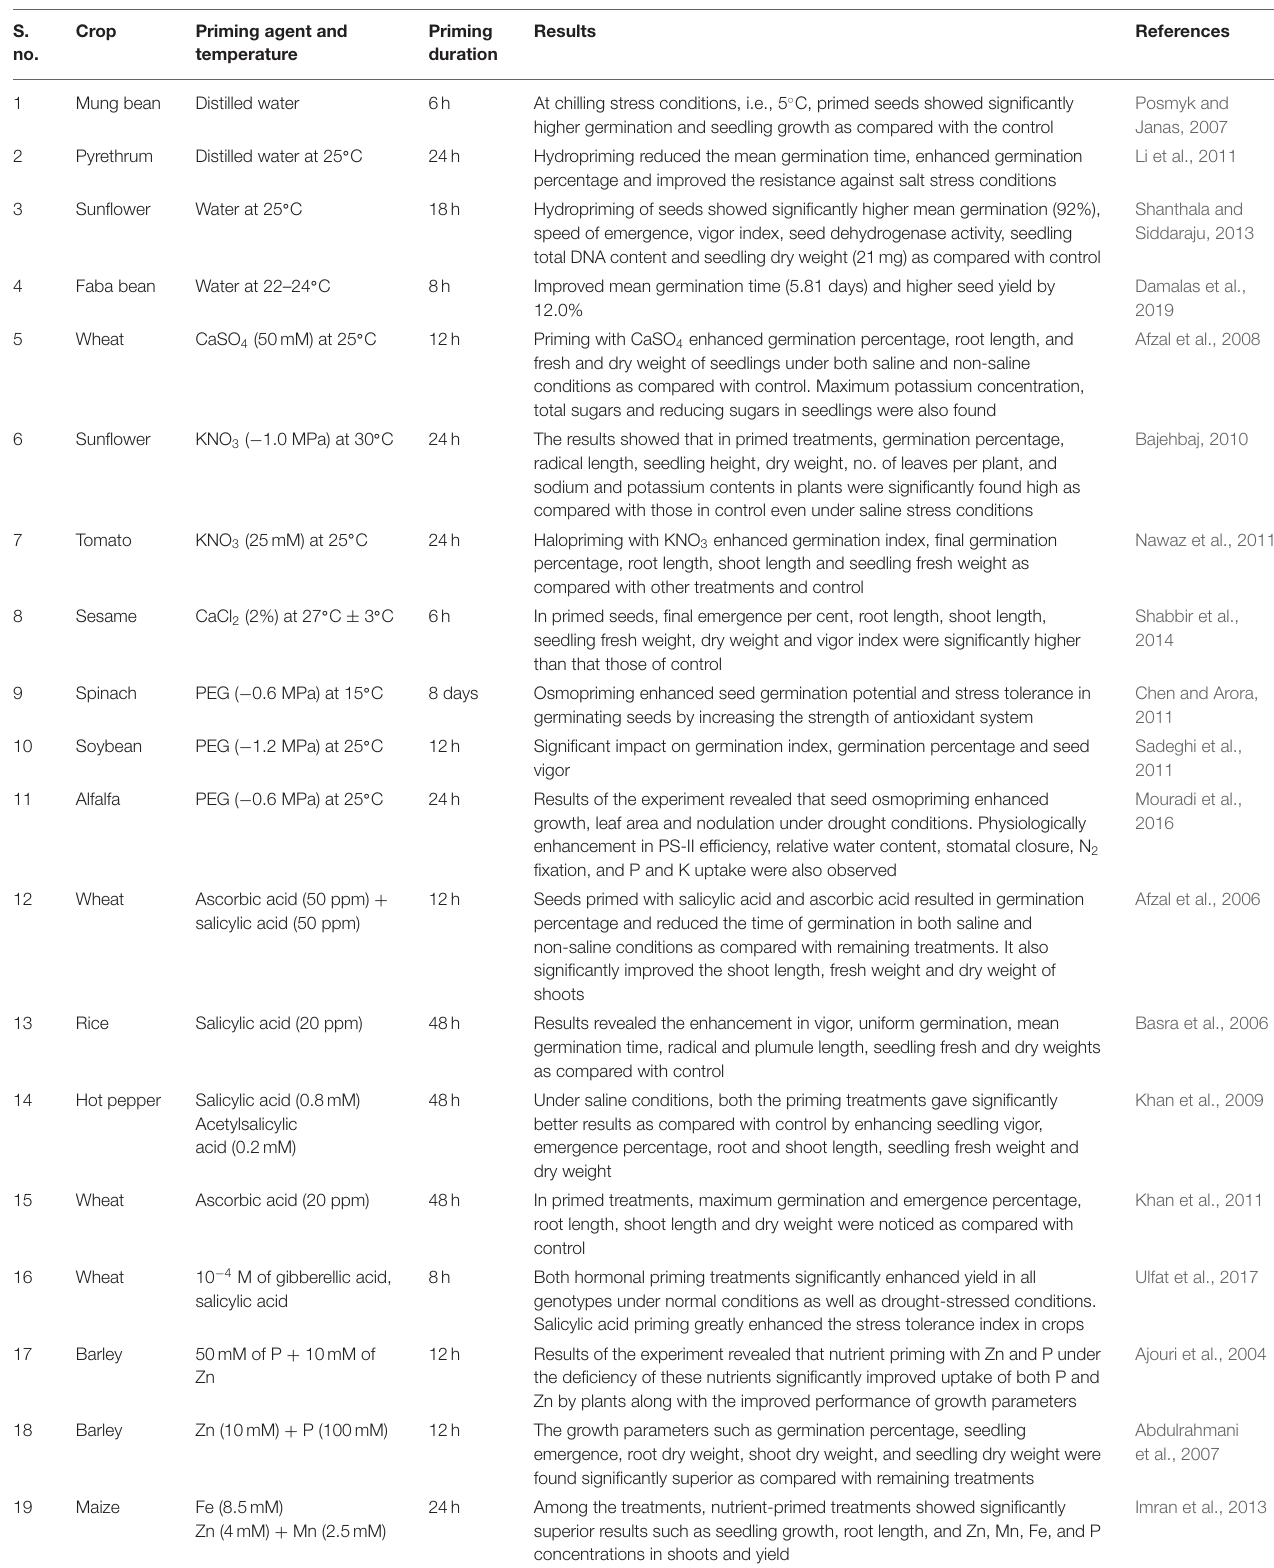
TABLE 2 | Role of priming in improving plant performance. S.